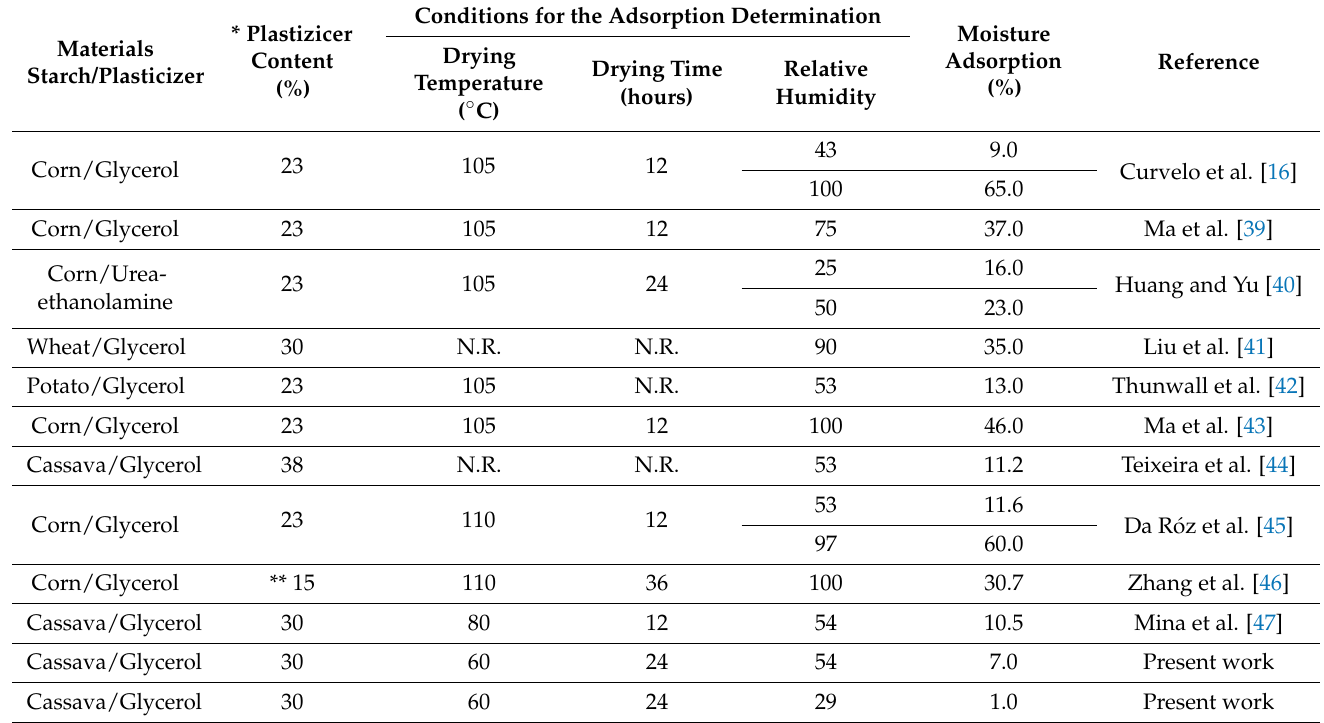
Table 2. Moisture adsorption values reported for thermoplastic starches at different storage conditions.